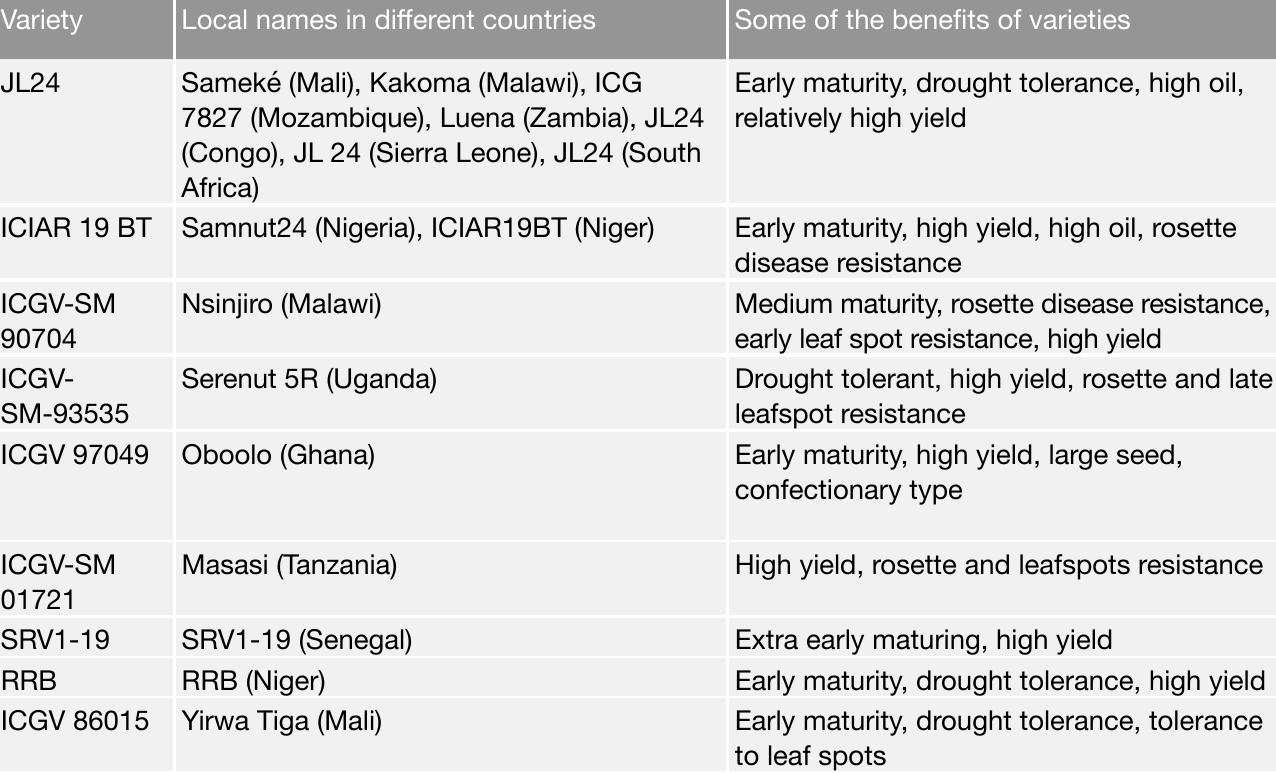
Table 1 : Some improved groundnut varieties and the benefits associated with them.